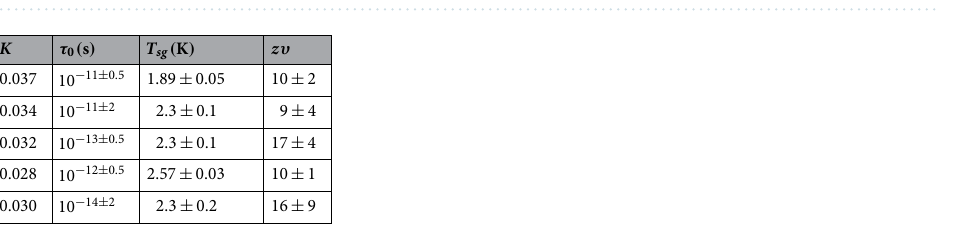
Table 2. x indicates the fraction of Ga in CuAl 2(1-x) Ga 2x O 4 . Columns 2–5 are parameters derived from Eqs. (4) 3Oe and (5). H ac =